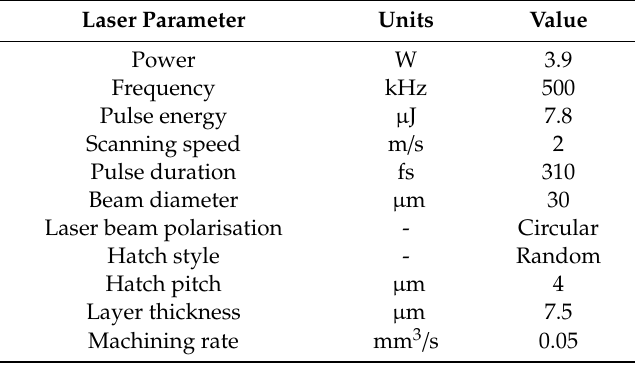
Table 2. Optimised laser parameters for the laser machining